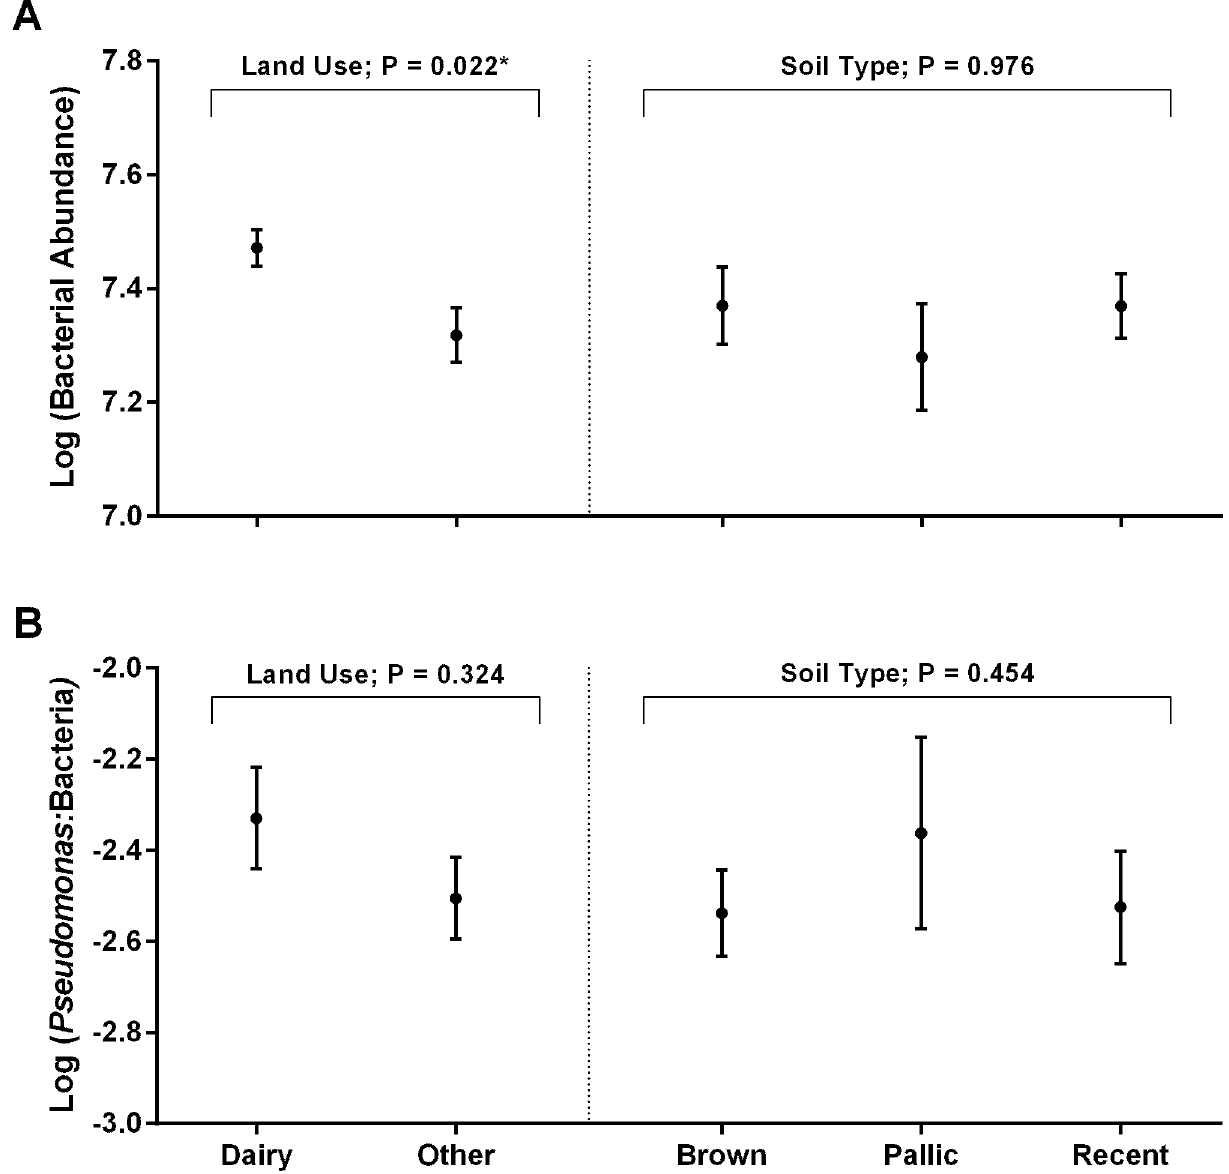
Fig 2. Influence of land use and soil type on (A) the abundance of the total bacterial community and (B) the relative abundance of the Pseudomonas community (mean ± SEM). The size of the total bacterial and Pseudomonas communities were determined by quantitative PCR. The effects of land use and soil type were formally tested by REML analysis (Genstat). Samples were characterized by land use as either high intensity ‘dairy’ systems or ‘other’, relatively lower intensity pasture systems, e.g. sheep and beef grazing